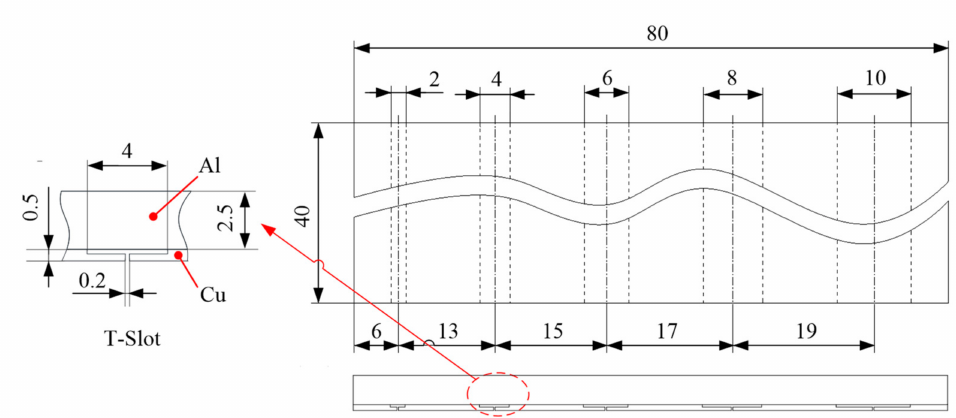
Figure 3. Cu/Al bimetallic composites